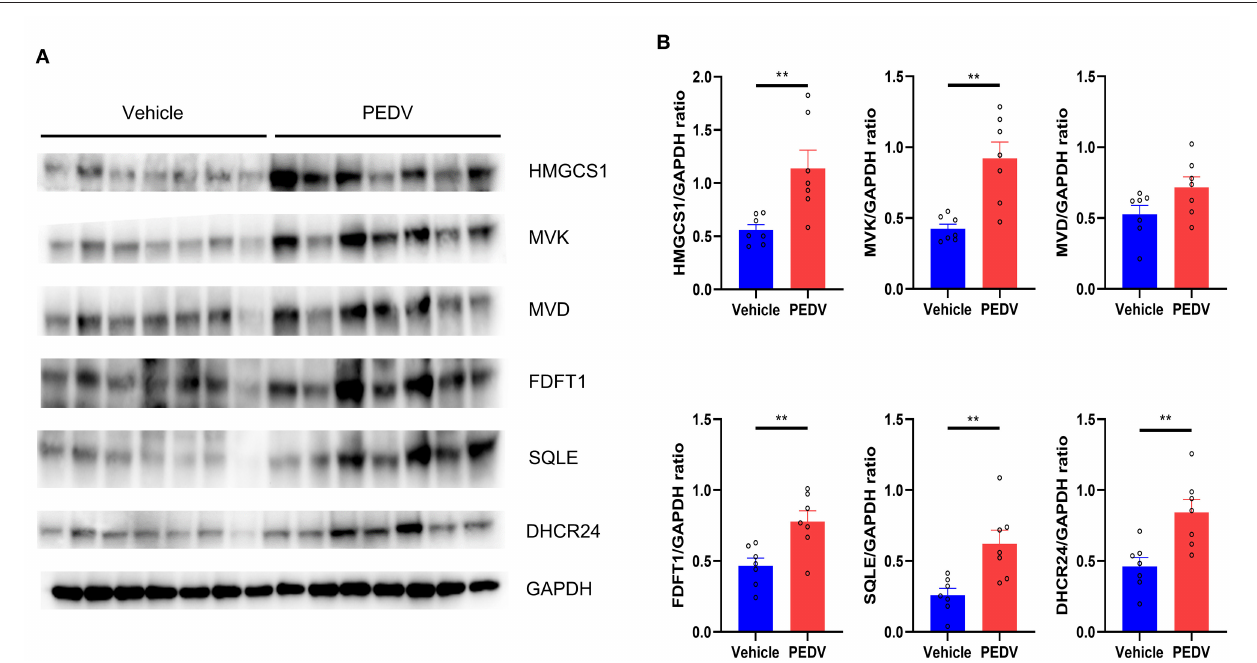
FIGURE 3 | The expression of core genes in the cholesterol biosynthesis pathway was upregulated at the protein level. (A) Western blotting analysis was conducted to evaluate the expression of HMGCS, MVK, MVD, FDFT1, SQLE, and 24-dehydrocholesterol reductase (DHCR24). (B) The relative expression levels of these genes were normalized to the housekeeping gene GAPDH. The data are shown as the means ± SEM, n = 7, ** P < 0.01, using the two-tailed Student t -test.